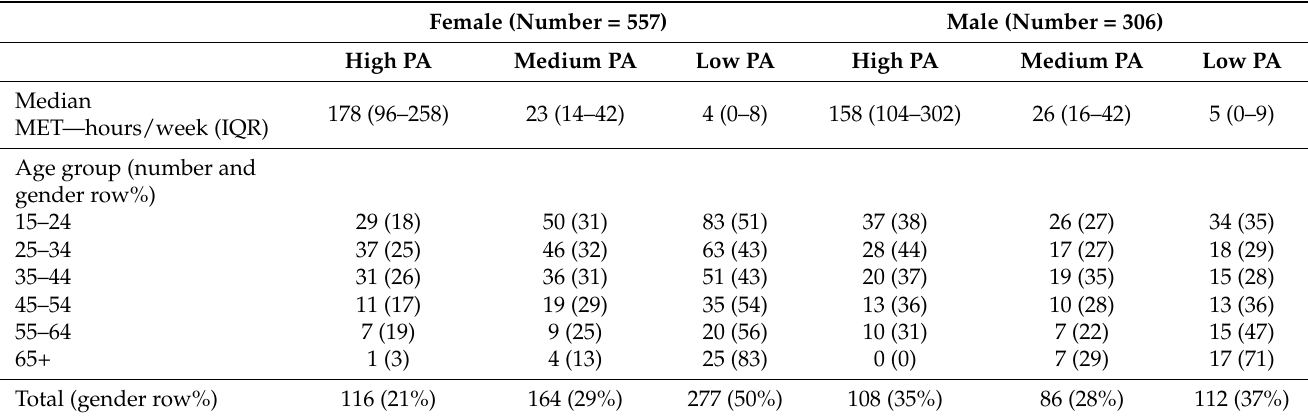
Table 2. Physical activity volume by age and gender from GPAQ in the city of Accra.